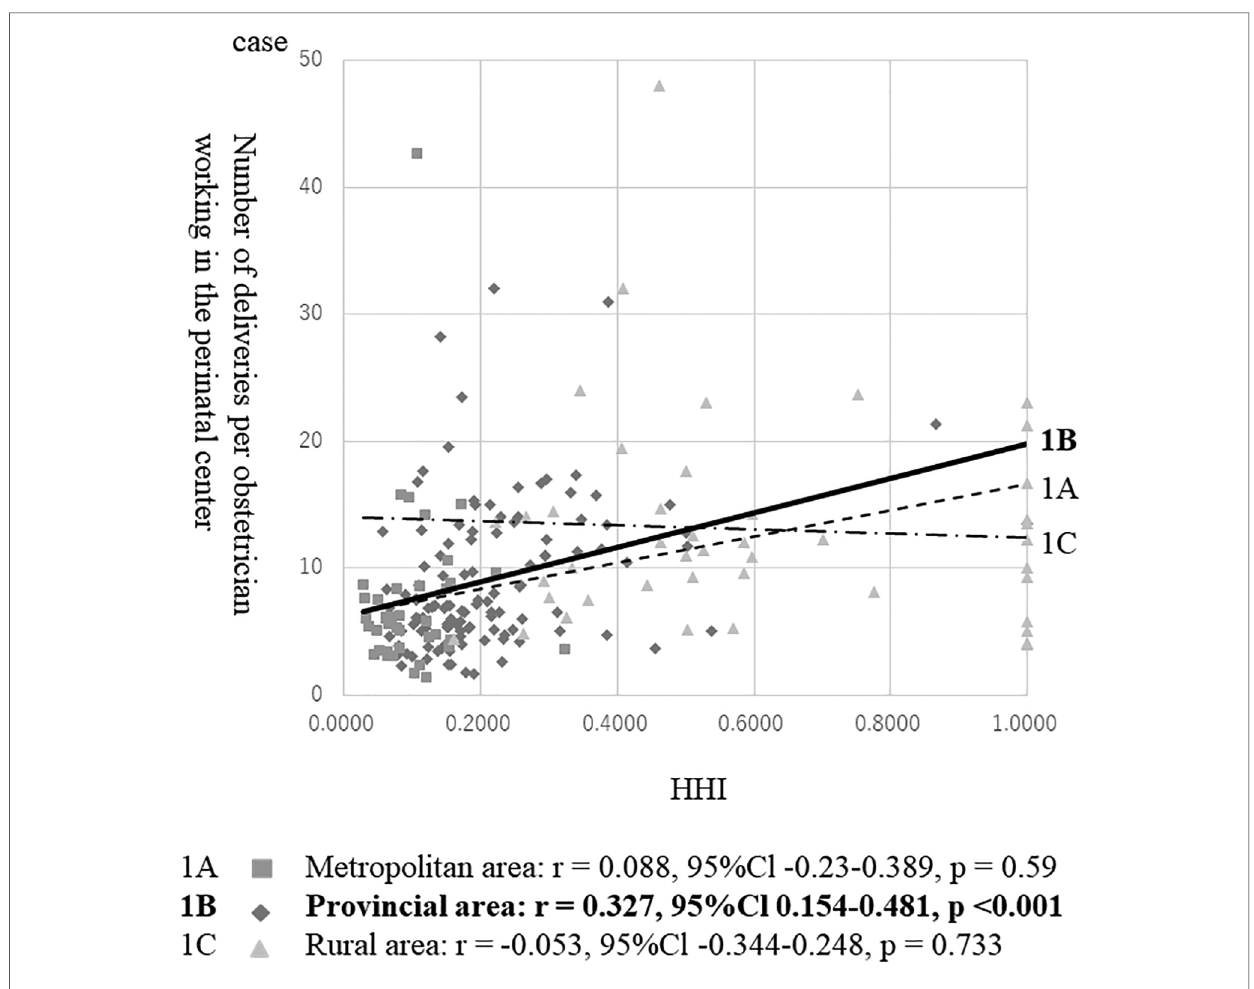
FIGURE 1 Correlation between HHI and the number of deliveries per obstetrician working in the perinatal center. CI, con fi dence interval. Note: The analysis excludes perinatal care areas without perinatal